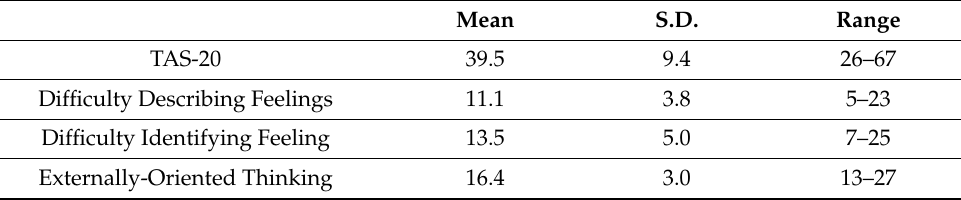
Table 5. TAS-20; Externally-Oriented Thinking; Difficulty Identifying Feeling; Externally-Oriented Thinking Mean scores, standard deviations, and